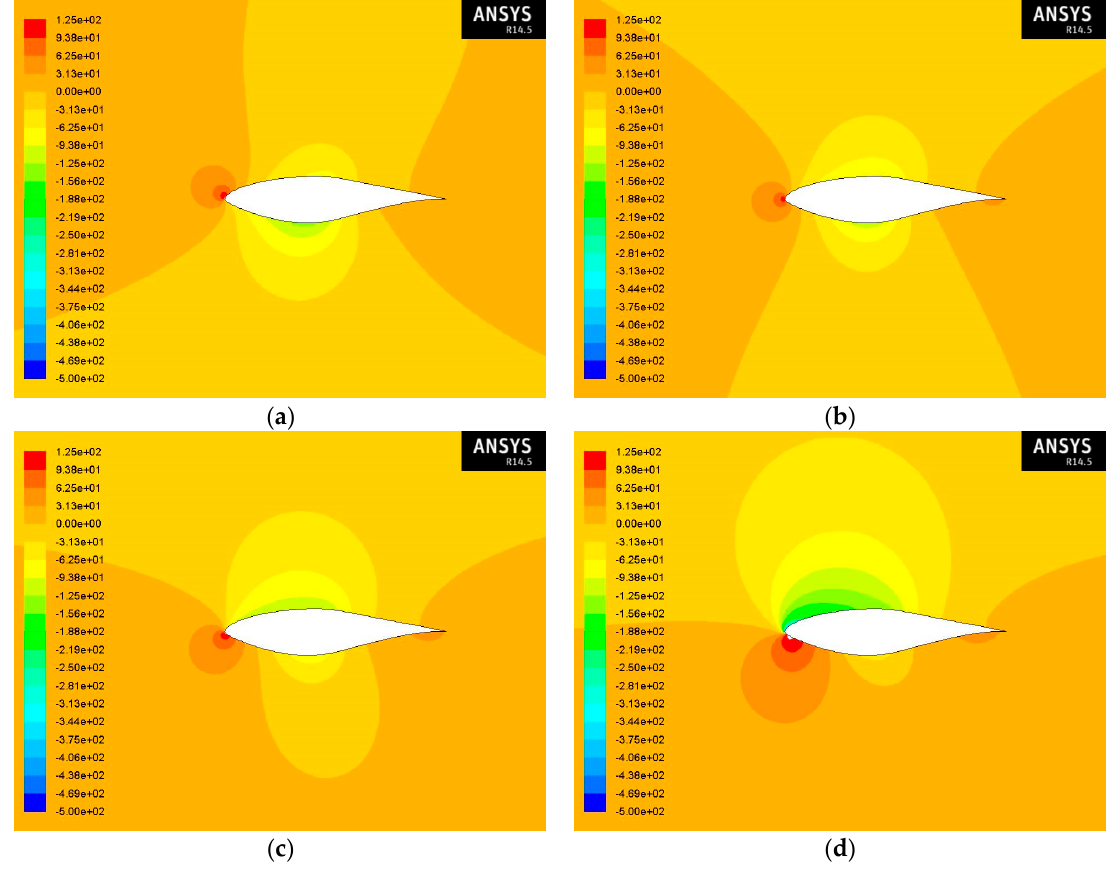
Figure 8. Contours of static pressure at ( a ) − 3°; ( b ) 0°; ( c ) 3°; and ( d ) 9° angles of attack at Re = 1 × 10 6 with the realizable k– ε turbulence model for an S809 airfoil for air-sand particle two-phase flow and 1% concentration of sand particles in the air.